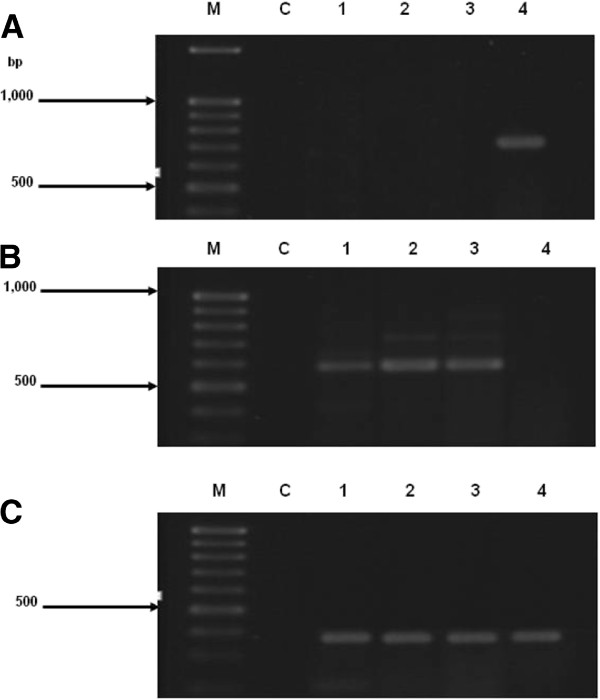
Expression patterns of AciHBGase I and II in A. cerana indica. The RT-PCR products amplified by the specific primer pairs for (A) AciHBGase I and (B) AciHBGase II with (C) the control profile of 28S rDNA amplification. In each figure, lane M contained 100 bp DNA ladder marker, lane C was the negative control (no reverse transcriptase), and lanes 1-4 contained RT-PCR products from eggs, larvae, pupae and adult foragers, respectively. Gels shown are representative of those seen from three independent trials.